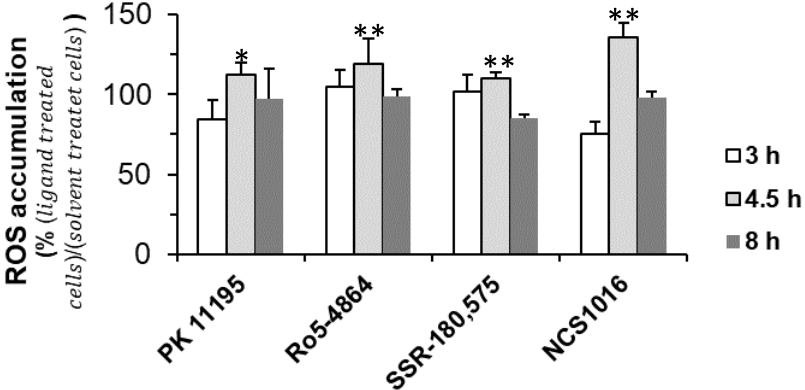
Figure 3. Reactive oxygen species (ROS) induced by TSPO ligands in the presence of ZnPPIX. Infected RBC at 2 to 5% parasitemia were incubated in the presence of 20 µM ZnPPIX and 50 µM TSPO ligands. At several time points samples were washed and incubated with DCFDA and analyzed by flow cytometry. MFI values were normalized to control background levels. No compensation was needed as monostained samples showed no interference between ZnPPIX and the ROS probes. Data are presented as the mean ± SEM; N = 8. Statistical analyses were performed for each ligand and control condition. Differences were considered significant when * p < 0.05; ** p <